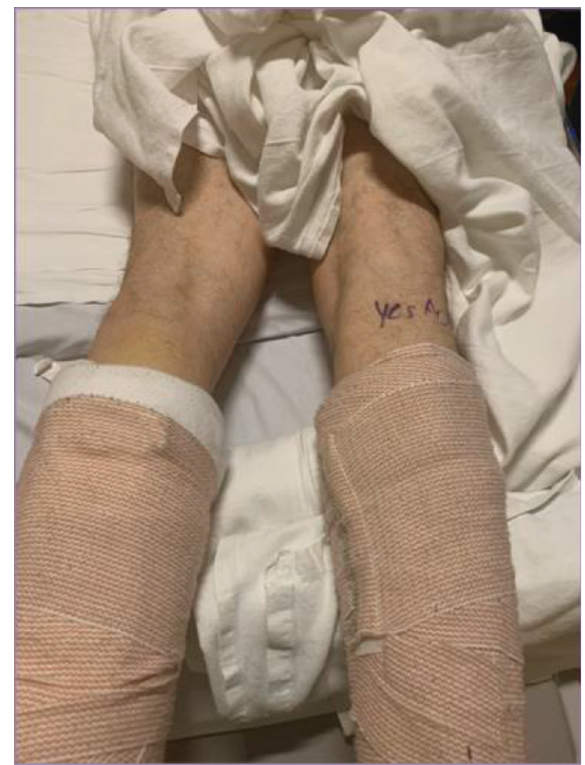
Figure 2: The patient was repositioned supine. The procedural mark was not visualized during the pause point because the team began to prepare the opposite (left, nonsurgical) leg (Case 2).